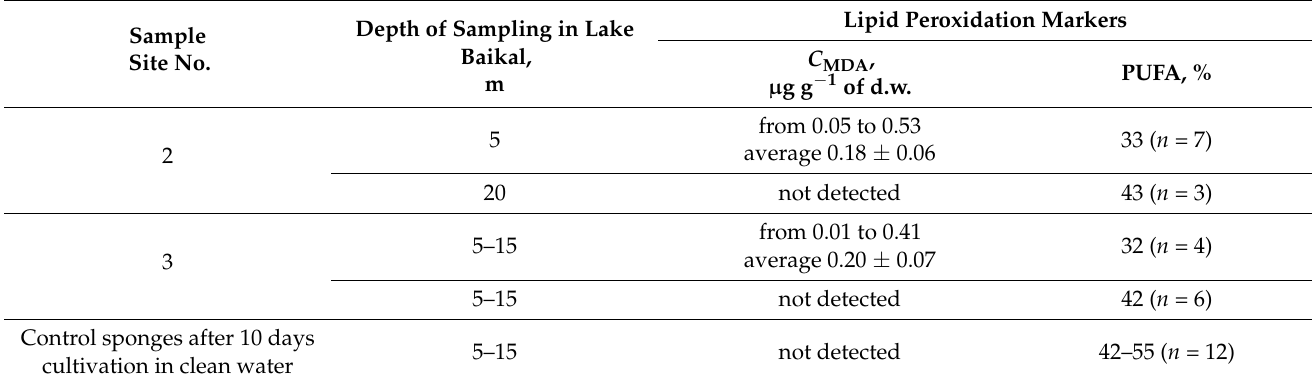
Table 2. Lipid peroxidation in Lubomirskia baikalensis collected in Lake Baikal from two sampling sites of different anthropogenic load in 2019.